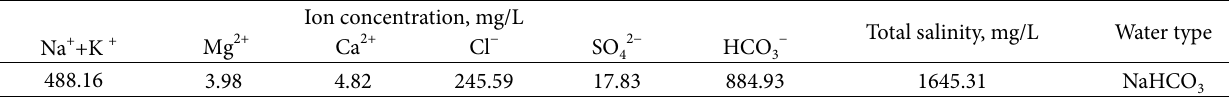
Table 2: Parameters of formation water from the No. 3 coal seam.